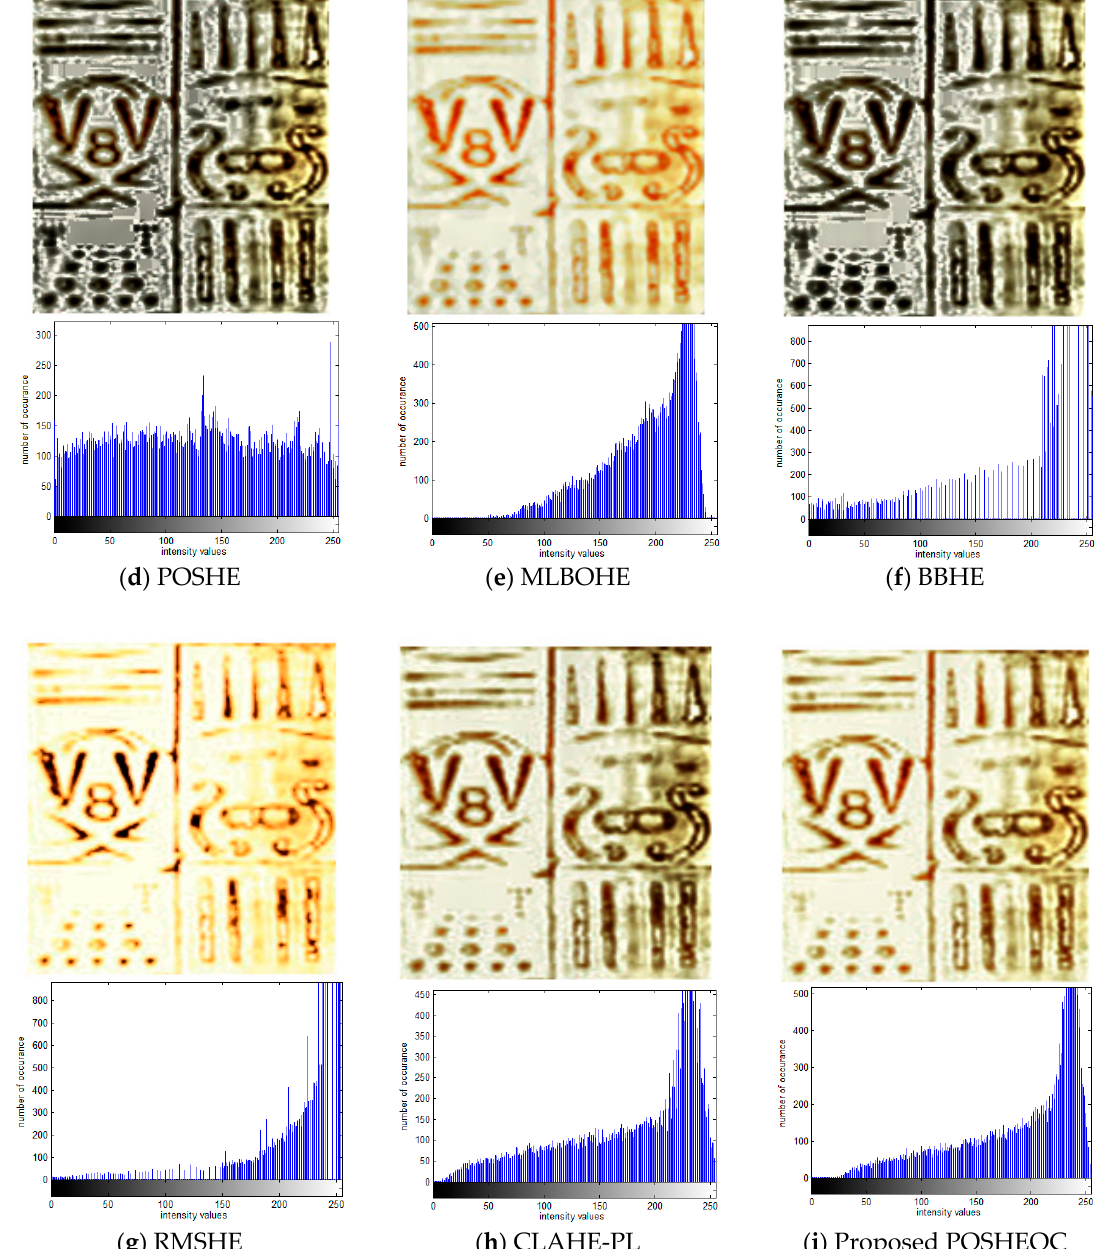
Figure 7. Comparison of enhancement results with corresponding statistical histogram using various techniques for ultrasonic logging image of the model well. ( a ) Original image; ( b ) HE; ( c ) BOHE; ( d ) POSHE; ( e ) MLBOHE; ( f ) BBHE; ( g ) RMSHE; ( h ) CLAHE-PL; ( i ) Proposed POSHEOC.